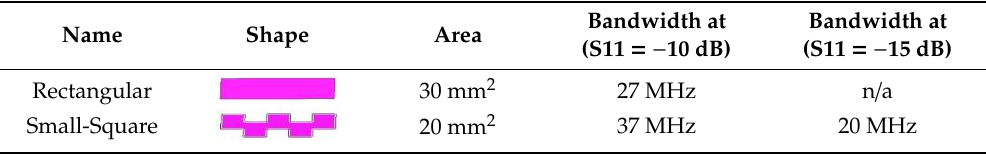
Table 3. Qualities and boundaries of tag antenna-end tip-loading.